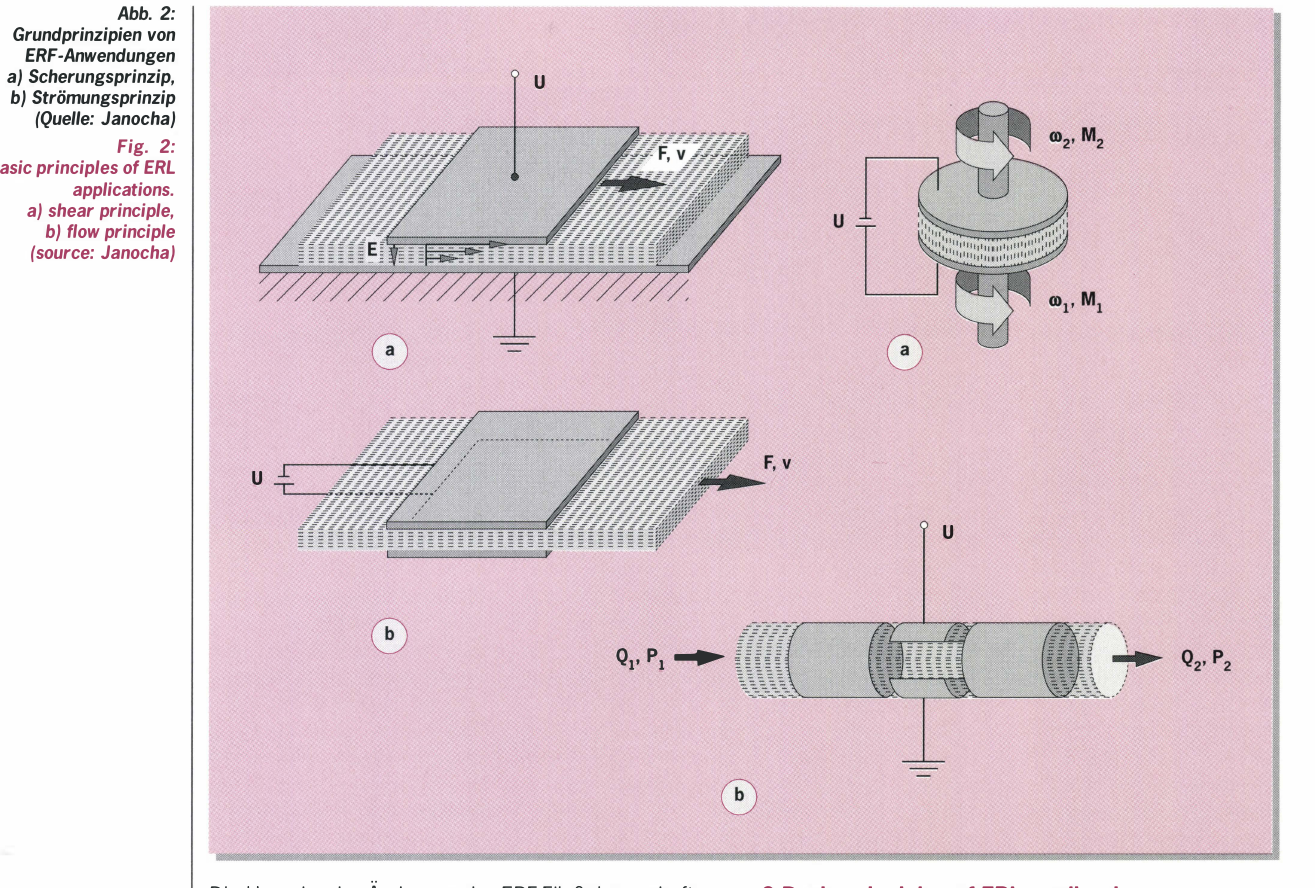
Fig. 2: Basic principles of